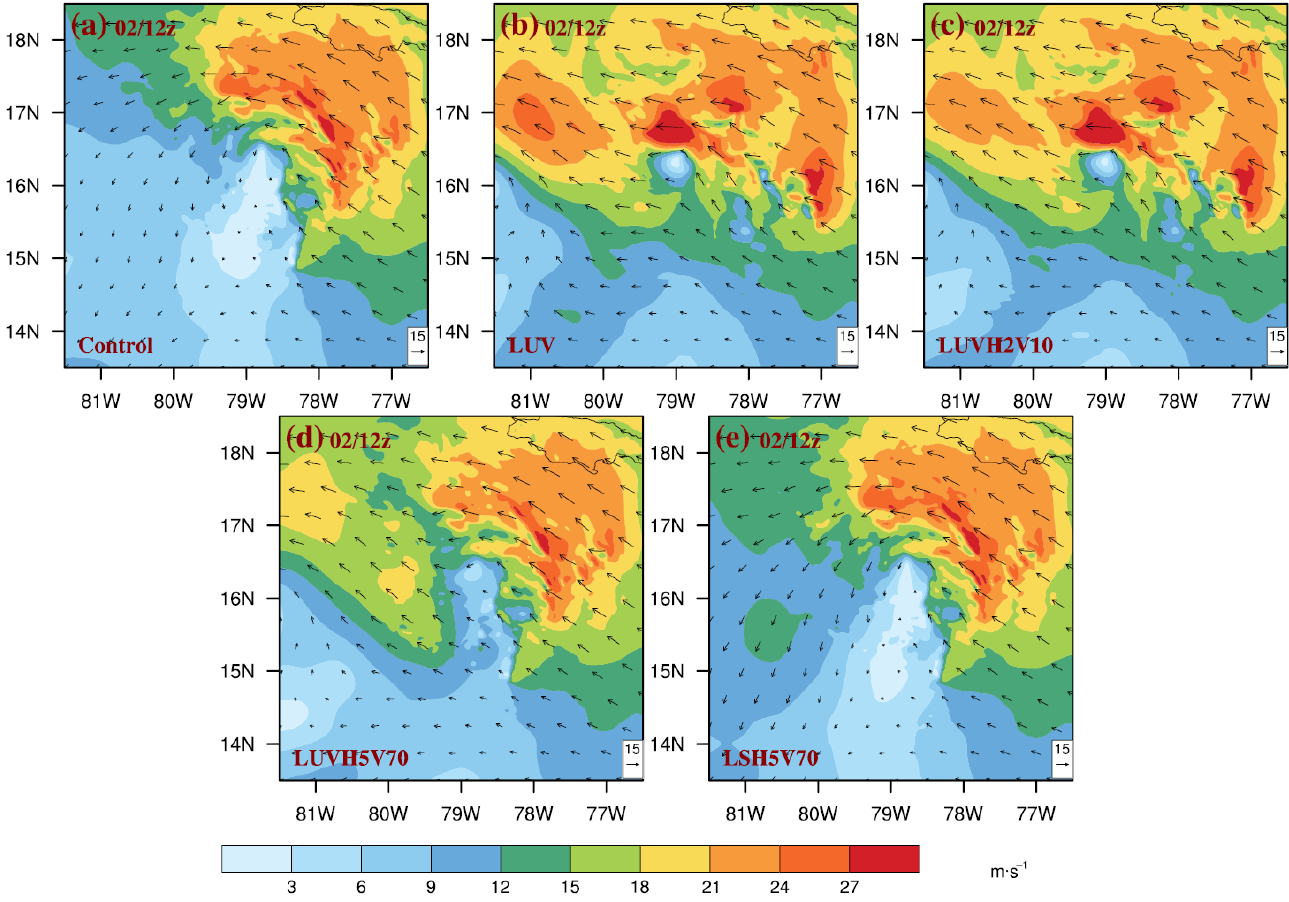
Figure 3. The 850 hPa wind analysis after data assimilation from ( a ) Control, ( b ) LUV, ( c ) LUVH2V10, ( d ) LUVH5V70, and ( e ) LSH5V70 for Hurricane Earl during landfall at 12 UTC 2 August 2016. Black arrows denote wind vectors (unit m·s −1 ). Table 2. Mean 36 h forecast errors from lidar wind speed and wind component data assimilation experiments.